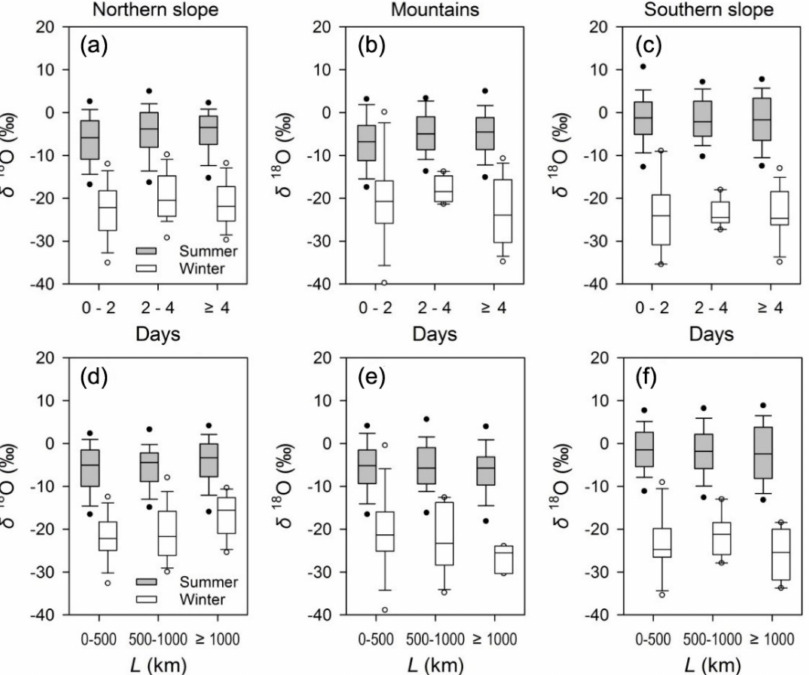
Figure 6. Relationship between transport time, in days ( a – c ) and distance ( d – f ), of the backward trajectory and δ 18 O in precipitation around the Tianshan